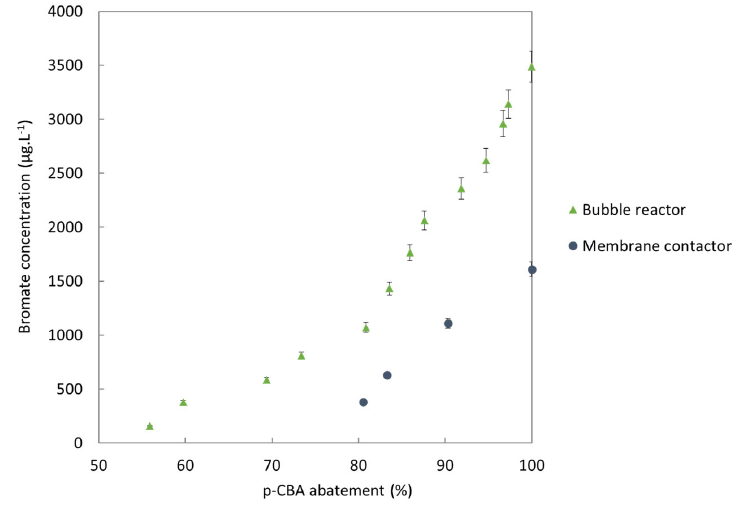
Figure 12. Evolution of bromate concentration as a function of p ‐ CBA abatement according to ozonation process used at pH 8.2.